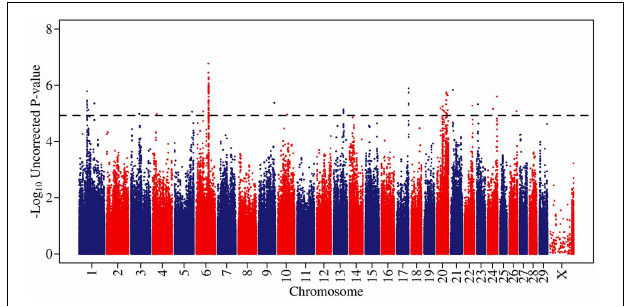
FIGURE 1 | A Manhattan plot of genome-wide associations for somatic cell score in 702 Holstein-Friesian sires. The − log 10 of the uncorrected p -values is shown for each SNP (y-axis). The genome-wide significance threshold is indicated by a dashed